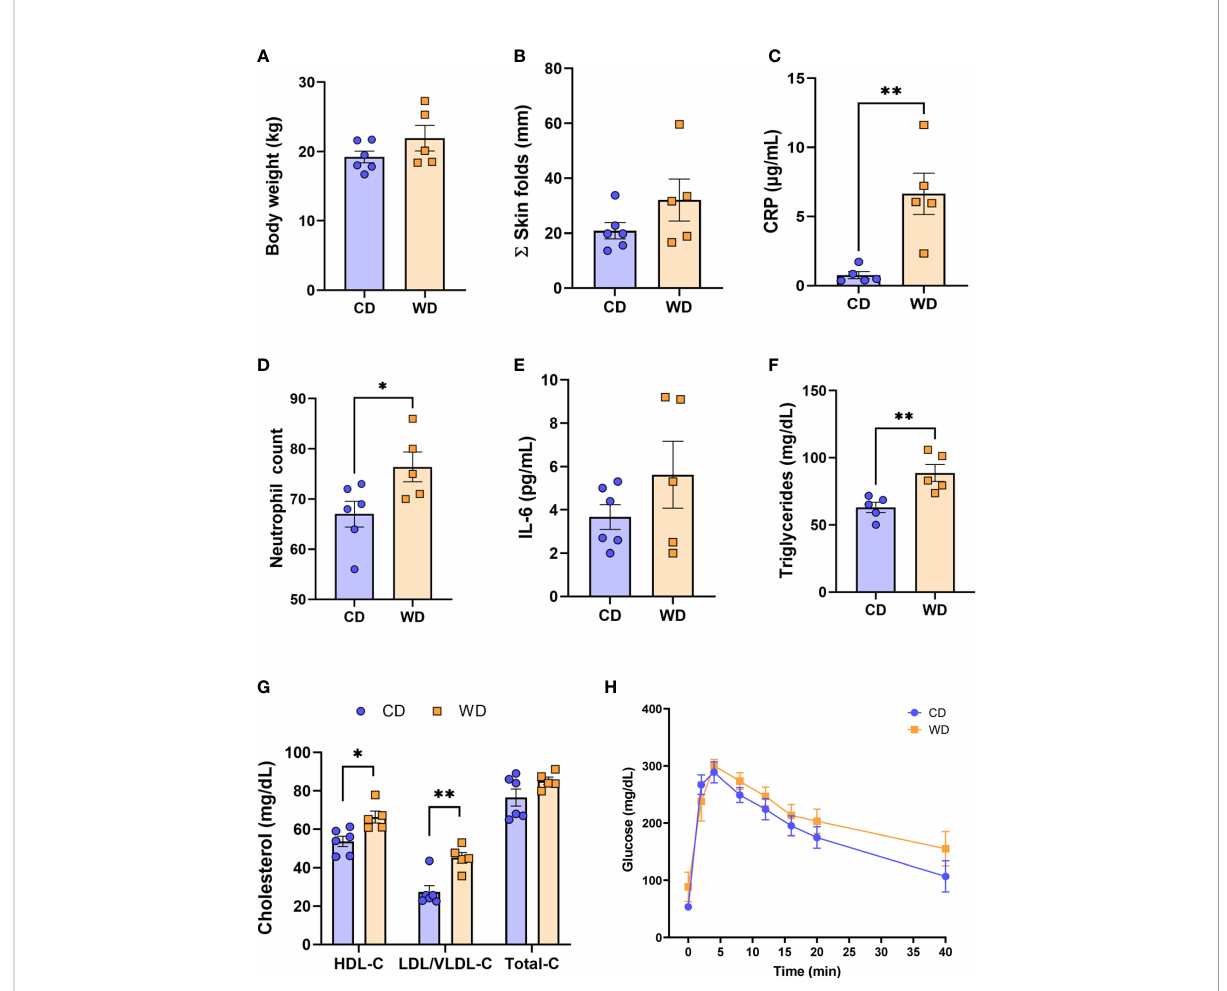
FIGURE 1 WD-fed dams exhibit alterations in in fl ammation and lipid metabolism at 0.6 gestation. Maternal body weight (A) , sum of ( S ) skin folds as a measure of adiposity (B) . Maternal serum levels of C-reactive protein ( CRP, C) , neutrophil count from complete blood count (D) , serum IL-6 levels (E) , and triglycerides (F) . Cholesterol analysis of red blood cells (G) and IVGTT analysis (H) . n = 5-6 CD and n = 5 WD. Unpaired 2-tailed Student ’ s t test was used to test signi fi cance. * P < 0.05, ** P <